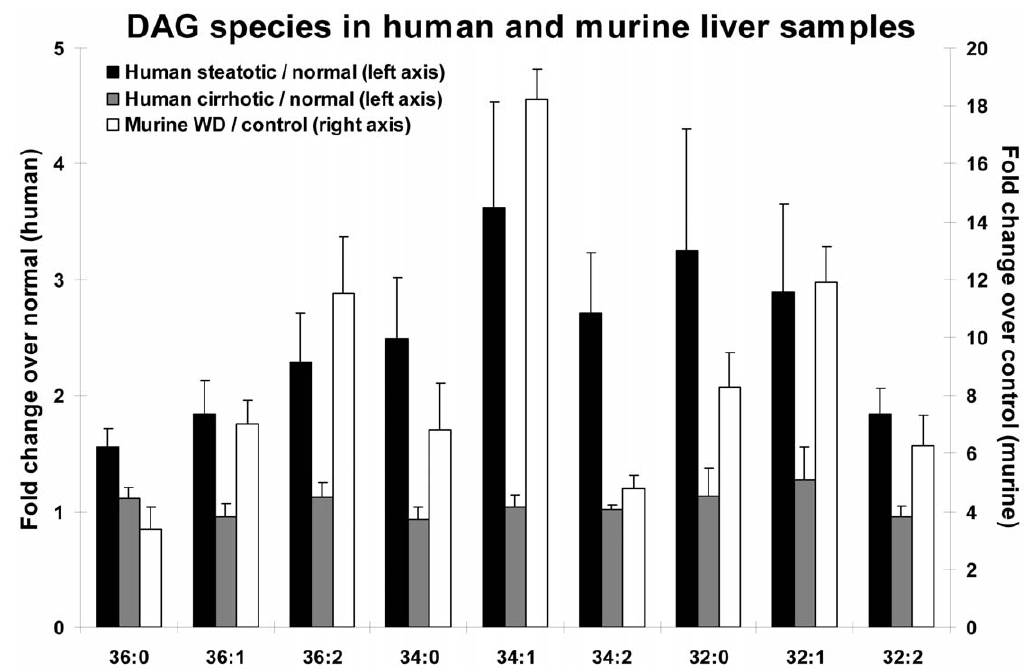
Figure 6. Principal component analysis of human lipidomics data. Human samples for different conditions: normal (dots), steatotic (crosses), cirrhotic (squares). All replicates are shown.